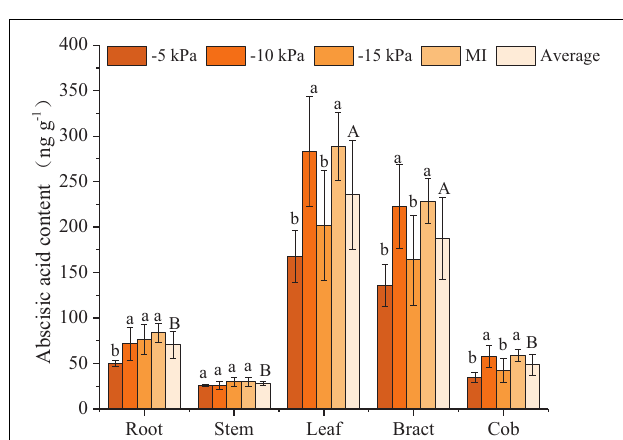
FIGURE 4 | Abscisic acid content in different organs of maize under different treatments. Values represent mean ± SD. The least significant difference method was used to test differences among treatments or organs at the P < 0.05 level. Different lowercase letters indicate significant differences among treatments within the same organ, and different capital letters on the average value of all treatments in each organ indicate significant differences among organs.